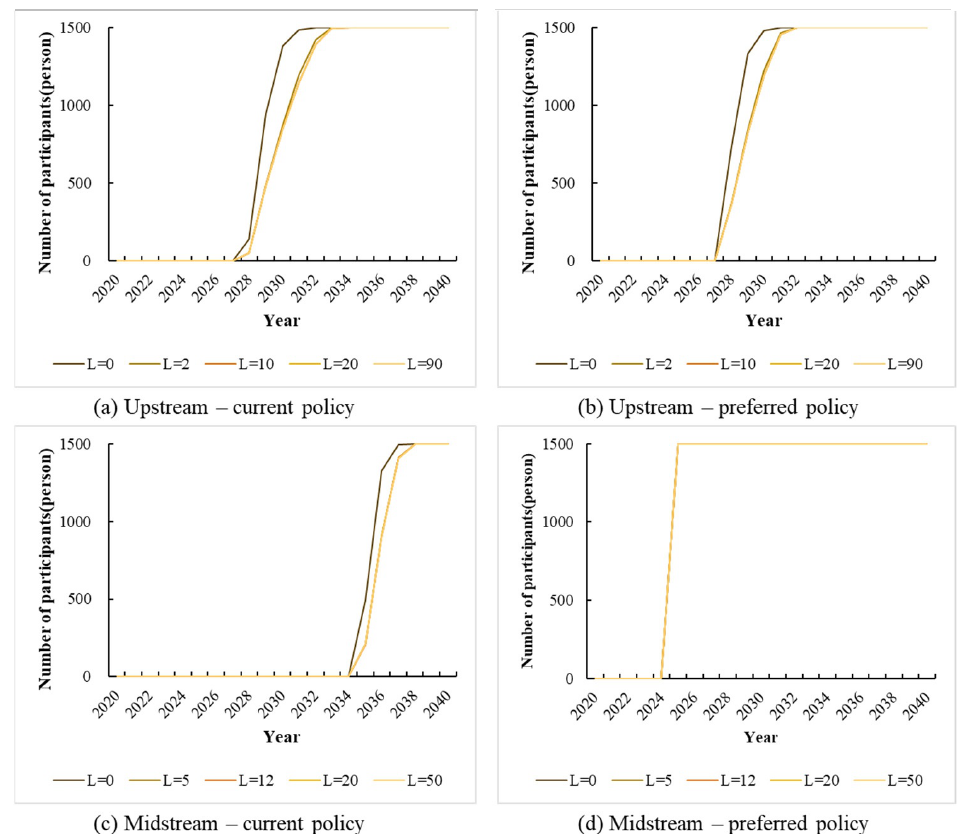
Figure 4. Impacts of different social network sizes in different scenarios. ( a ) the changes in the willingness of upstream farmers to participate in the current policy scenario; ( b ) the changes in the willingness of upstream farmers to participate in the policy preference scenario; ( c ) the changes of willingness of the midstream farmers to participate in the current policy scenario; ( d ) the changes in the willingness of upstream farmers to participate in the policy preference scenario.